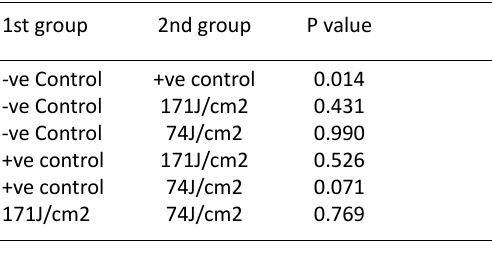
Table 13. Head circumferences comparison in day